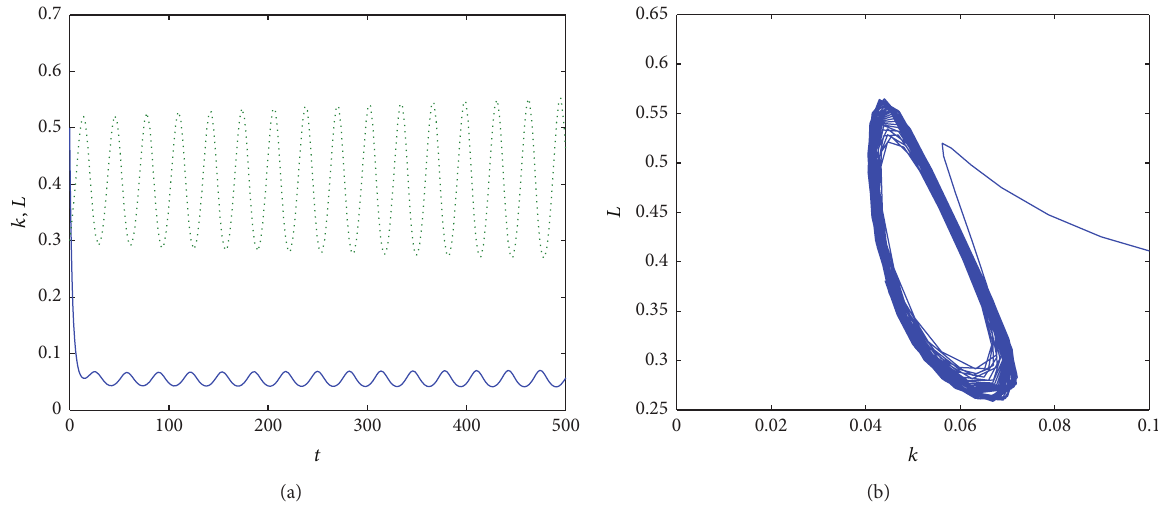
Figure 3: The time evolution of the functions 𝑘(𝑡) (dotted line) and 𝐿(𝑡) for 𝛼 = 0.8 , 𝑠 = 0.5 , 𝑎 = 0.2 , 𝑏 = 0.5 , 𝛿 = 0.9 , and 𝜏 = 8 (a). The phase space of 𝐿(𝑡) versus 𝑘(𝑡) for 𝑡 ∈ [0, 1000] (b).